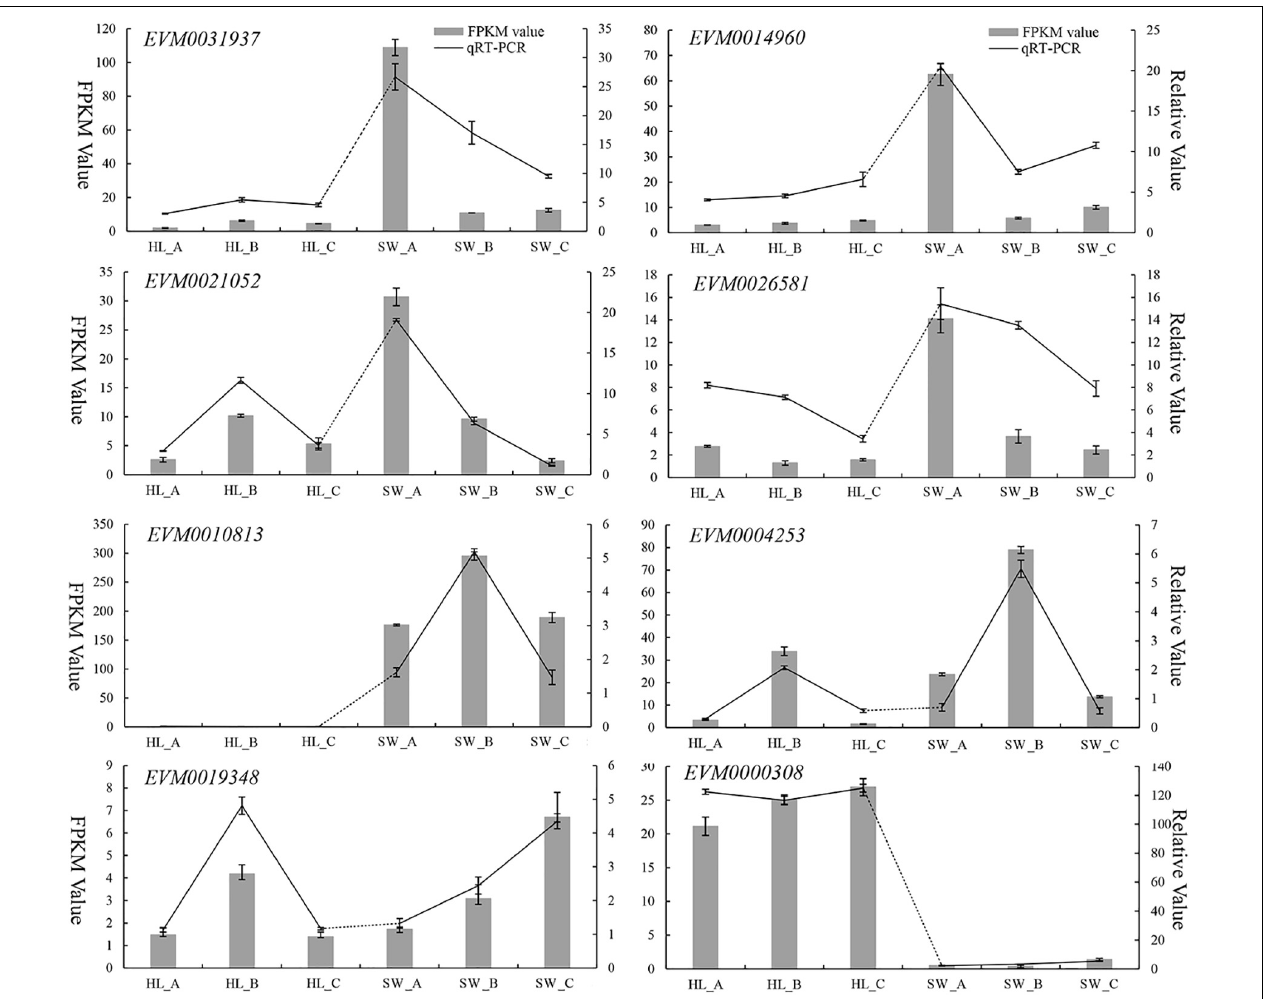
FIGURE 8 | Quantitative reverse-transcriptase (qRT)-PCR validation of DEGs expression in developing “HL” and “SW” chestnut buds vs. by RNA-Seq. dark line: qRT-PCR expression, gray bars: transcriptomics RNA-Seq analysis [fragments per kilobase per million reads